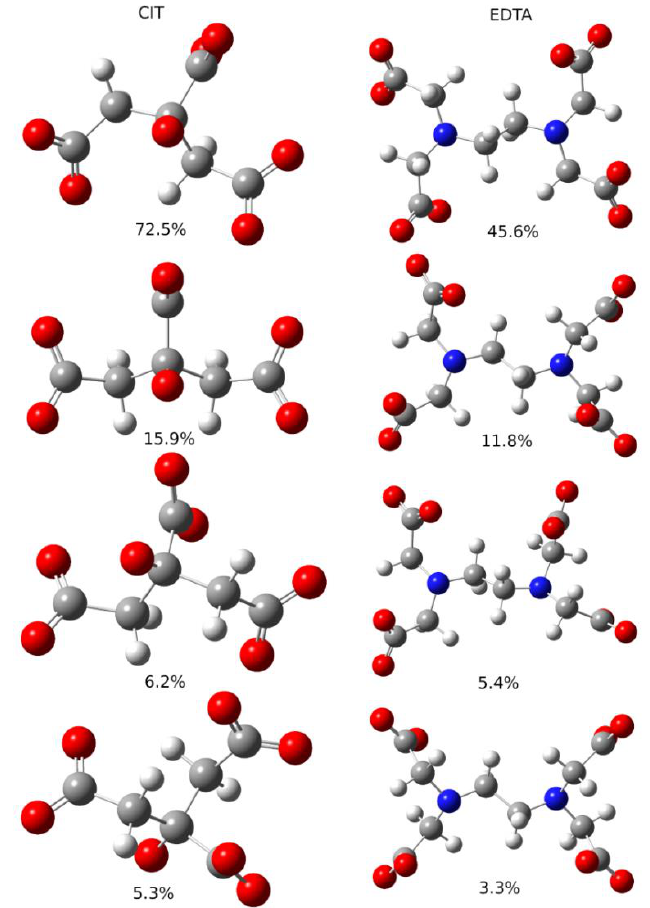
Figure 9. Most populated conformers of apo forms of Cit (left column) and EDTA (right column) molecules. Energies of molecules were calculated at BHANDHLYP/6-311 + G(d,p)/IEF-PCM level. Population of each conformer is given below its picture.